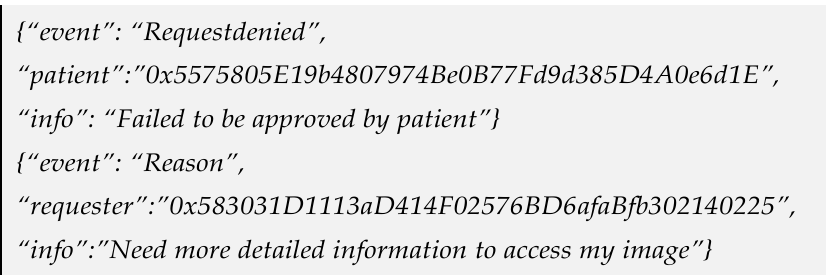
Figure 6. Case 1: event log for approving IR 1 address to access a patient medical image.